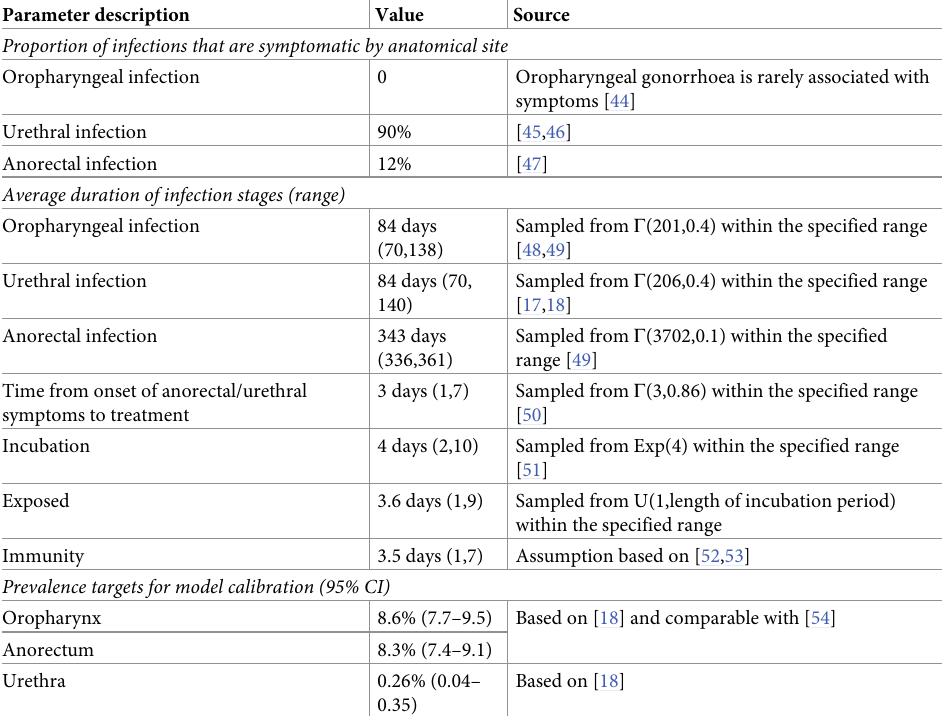
Table 1. Gonorrhoea infection parameters and prevalence targets for model